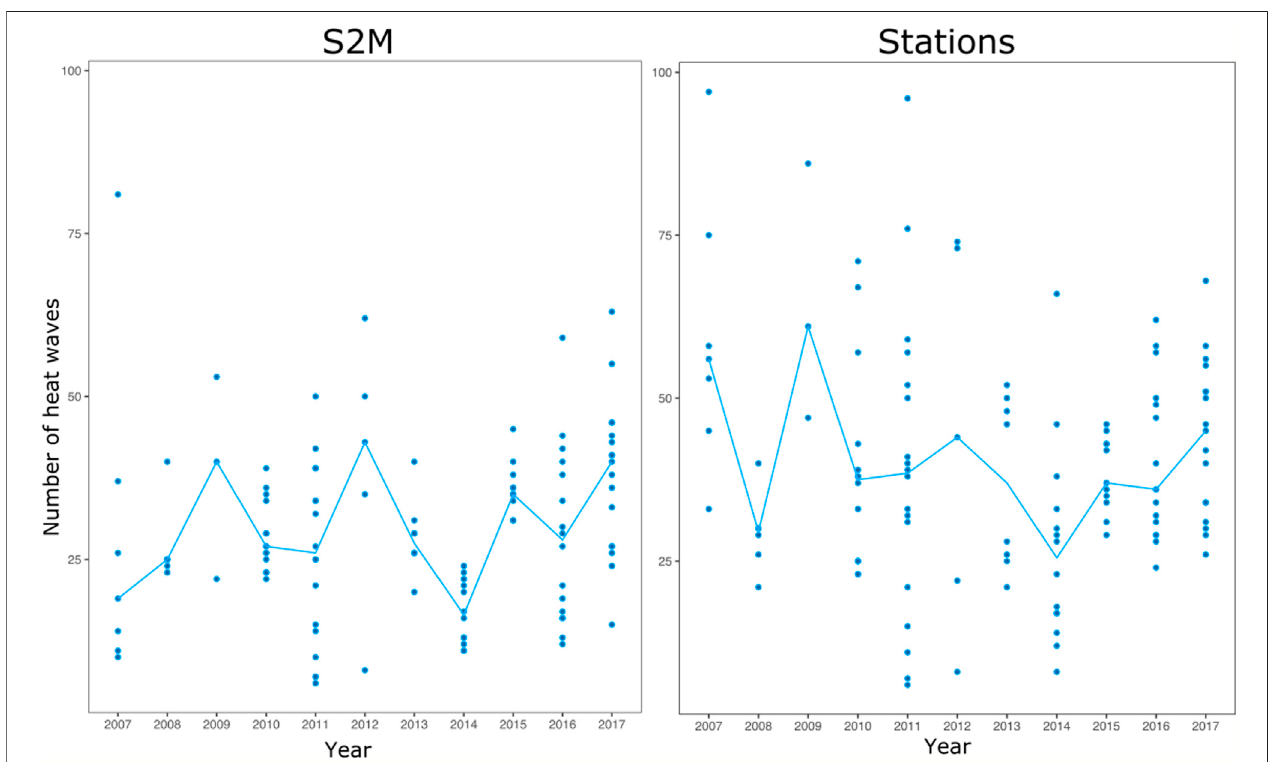
FIGURE 6 | Number of heat waves calculated from each station (points) and median among all stations for each year (blue line).